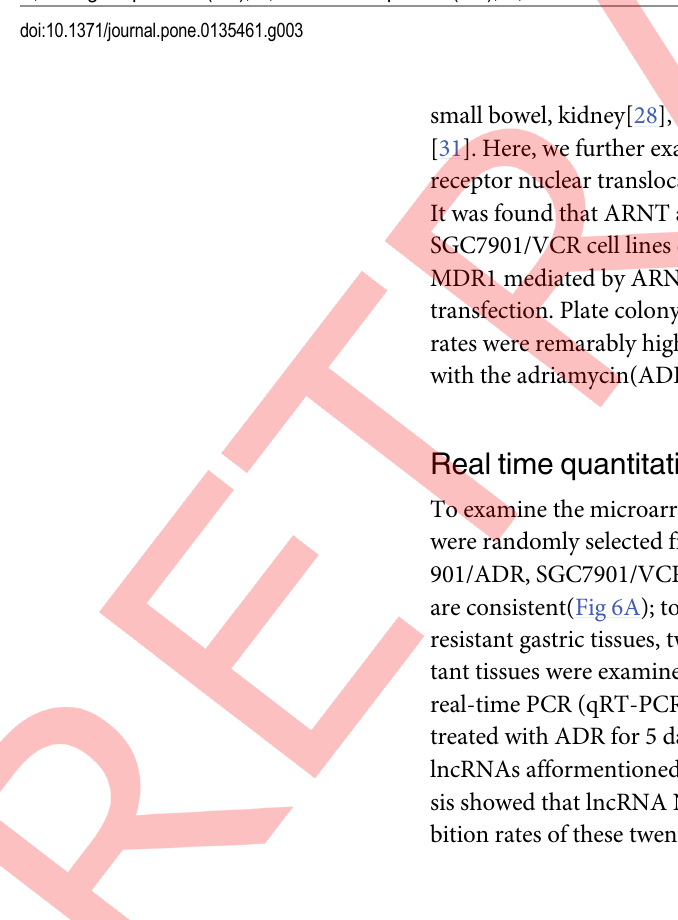
Fig 3. Pie charts showing the significant enrichment terms. The pie chart shows the top ten counts of the significant enrichment terms. The ontology covers three domains: Biological Process, Cellular Component and Molecular Function. Fisher ’ s exact test is used to find if there is more overlap between the DE list and the GO annotation list than would be expected by chance. The p-value denotes the significance of GO terms enrichment in the DE genes. The lower the p-value, the more significant the GO Term (p-value < = 0.05 is recommended) (A-C) The highest enriched GOs targeted by up-regulated transcripts: A, Biological process (BP), B, Cellular component (CC), C, Molecular function (MF). (D-F) The highest enriched GOs targeted by down-regulated transcripts: A, Biological process (BP), B, Cellular component (CC), C, Molecular function